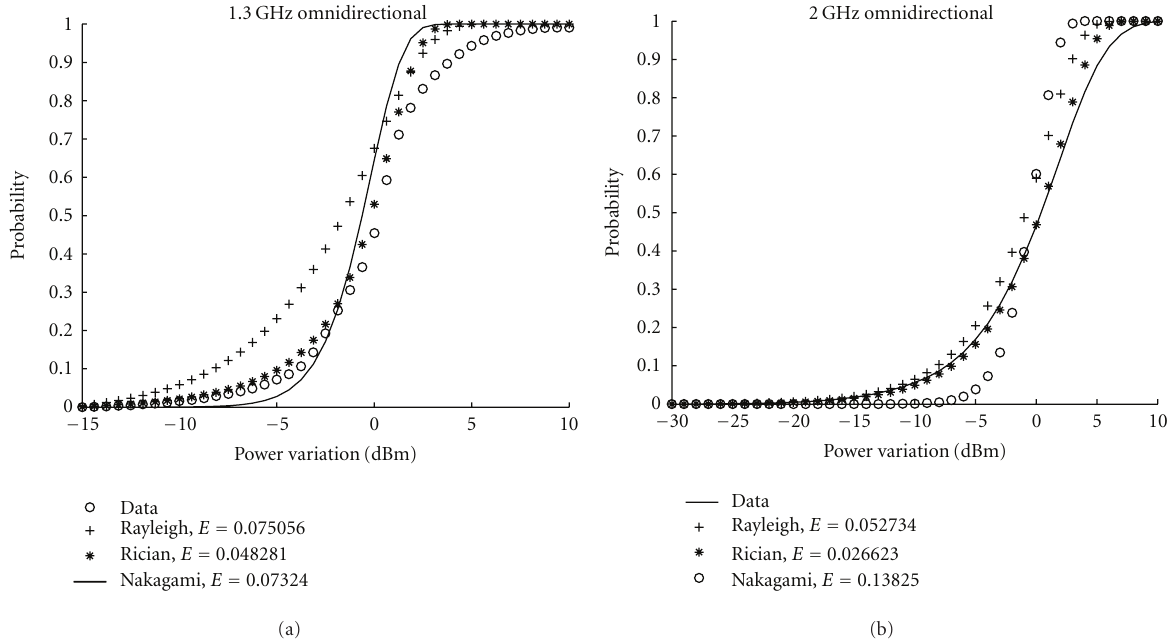
Figure 3: Small-scale signal variation in (a) canteen (large room) (b) A2.4 (small room).